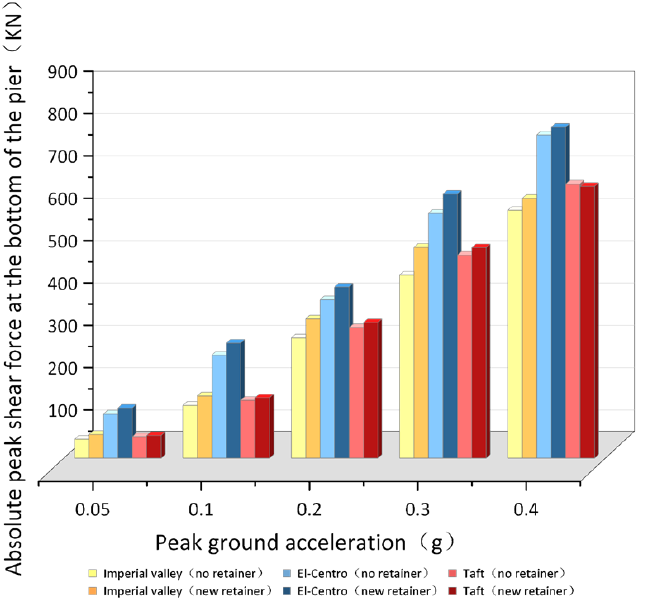
Figure 23. Contradistinction of the peak absolute shear force at pier